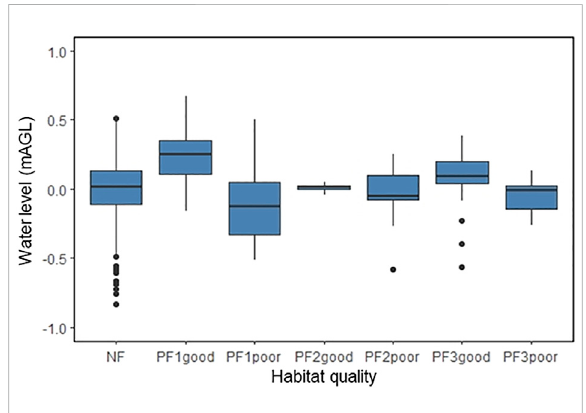
FIGURE 2 Phreatic water level in metres above ground level for Fossitt habitat de fi ned to be in good or poor ecological conditions. Non- fen habitats denoted as